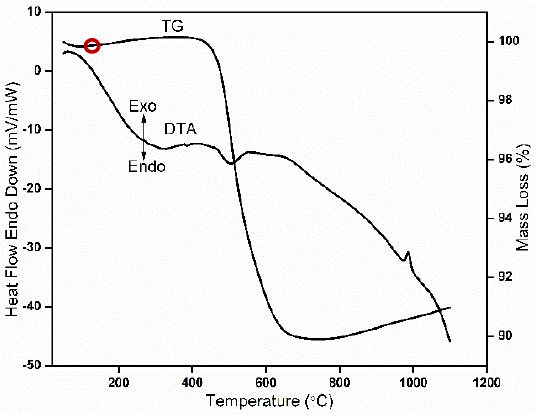
Figure 3. Thermogravimetric thermal analysis (TGA)/ differential thermal analysis (DTA) thermal analysis of green bodies.